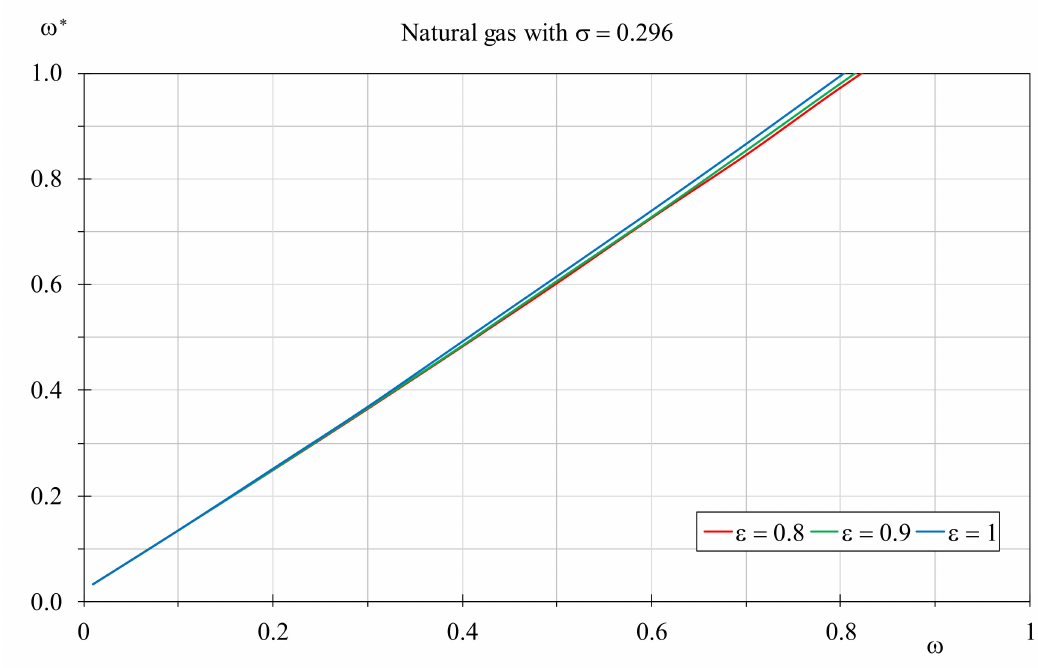
Figure 13. Required thermal capacity ratio ( ω *) to attain for hydrogen the same EQI of natural gas that supplies boiler operating with ω and dimensionless temperature factor of 0.296, for three different heat exchanger